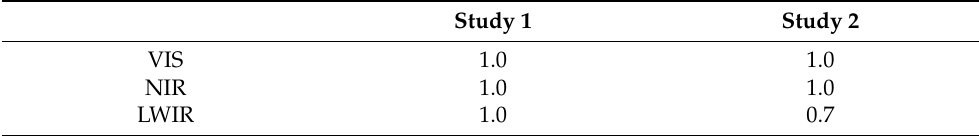
Table 8. W b values to be used for each spectral band in the different studies. Study 1 Study 2